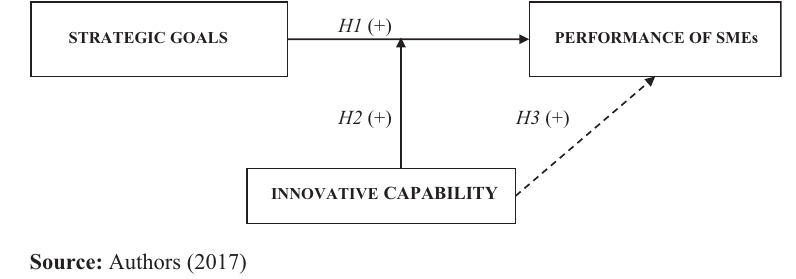
Figure 1. Conceptual